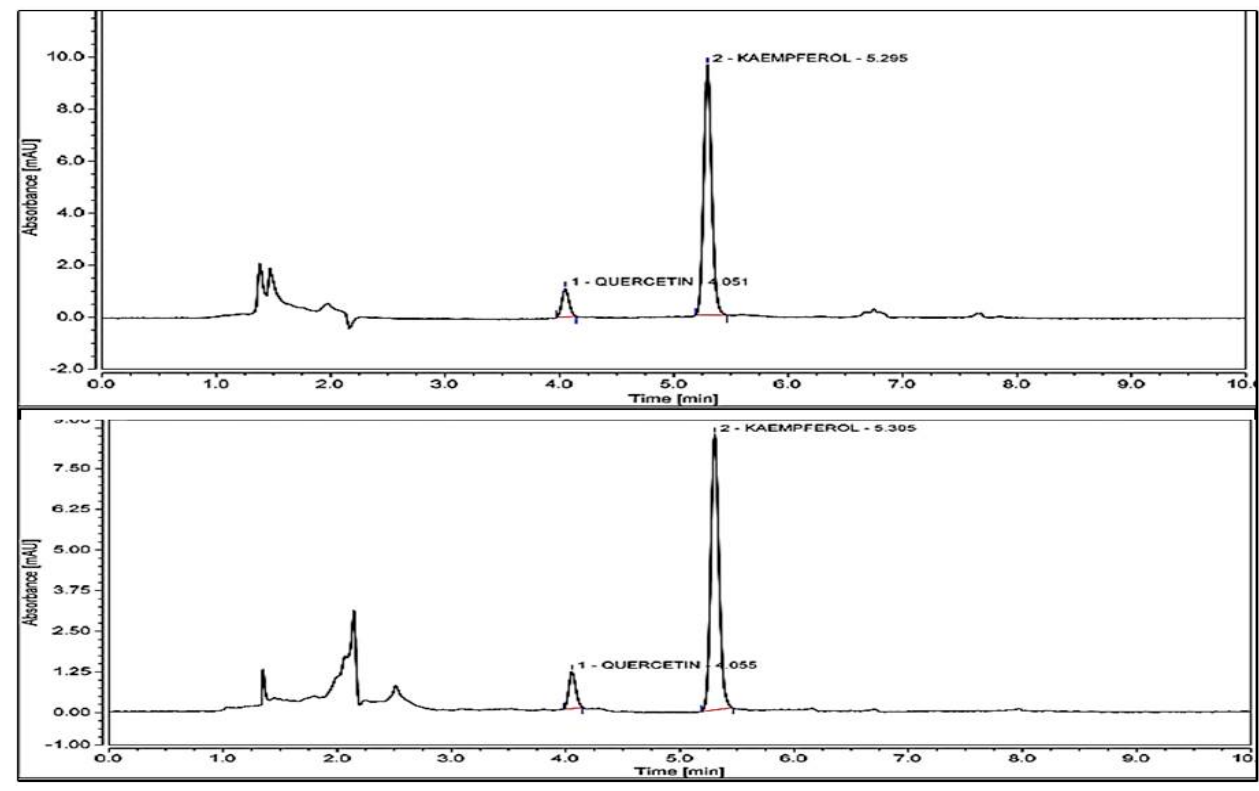
Figure 4. HPLC results for Kaempferol content of M. flexuosa 54.43 µg/g extract and T. grandiflorum 29.04 µg/g extract. Quercetin in both extracts registered below the limit of quantitation (<LOQ).